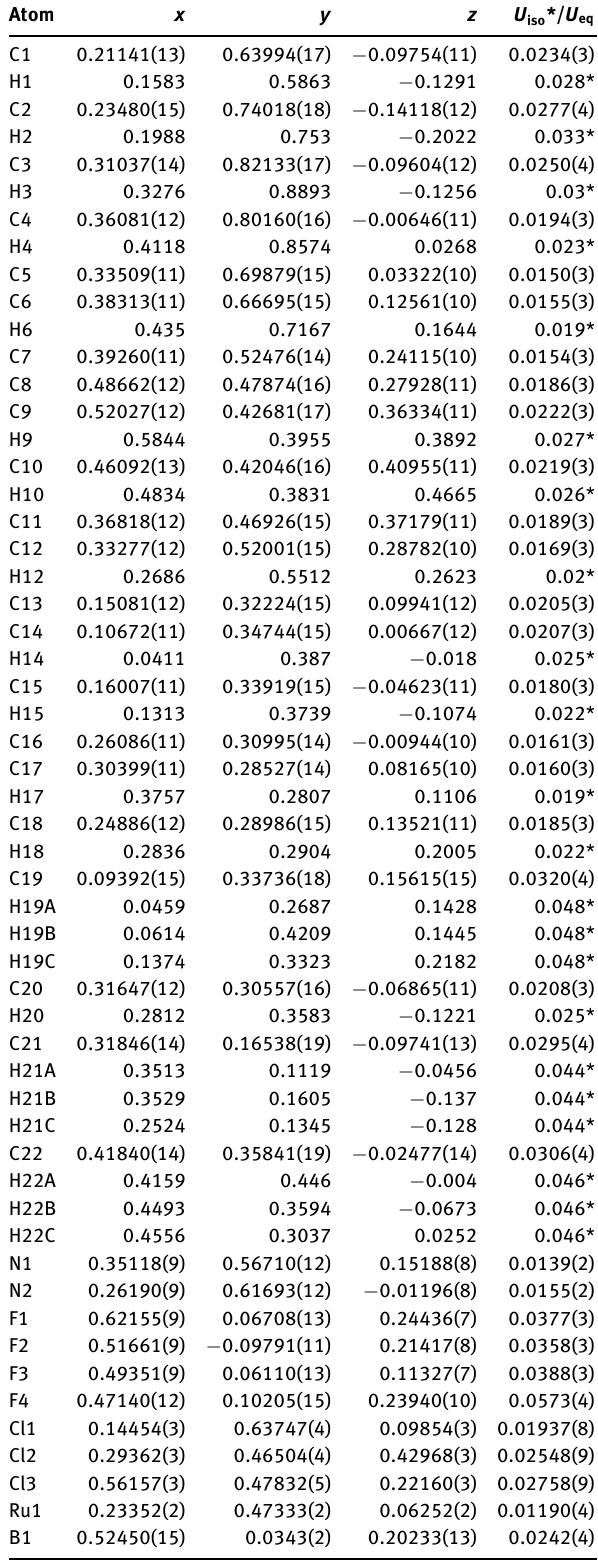
Table 2: Fractional atomic coordinates and isotropic or equivalent isotropic displacement parameters (Å 2